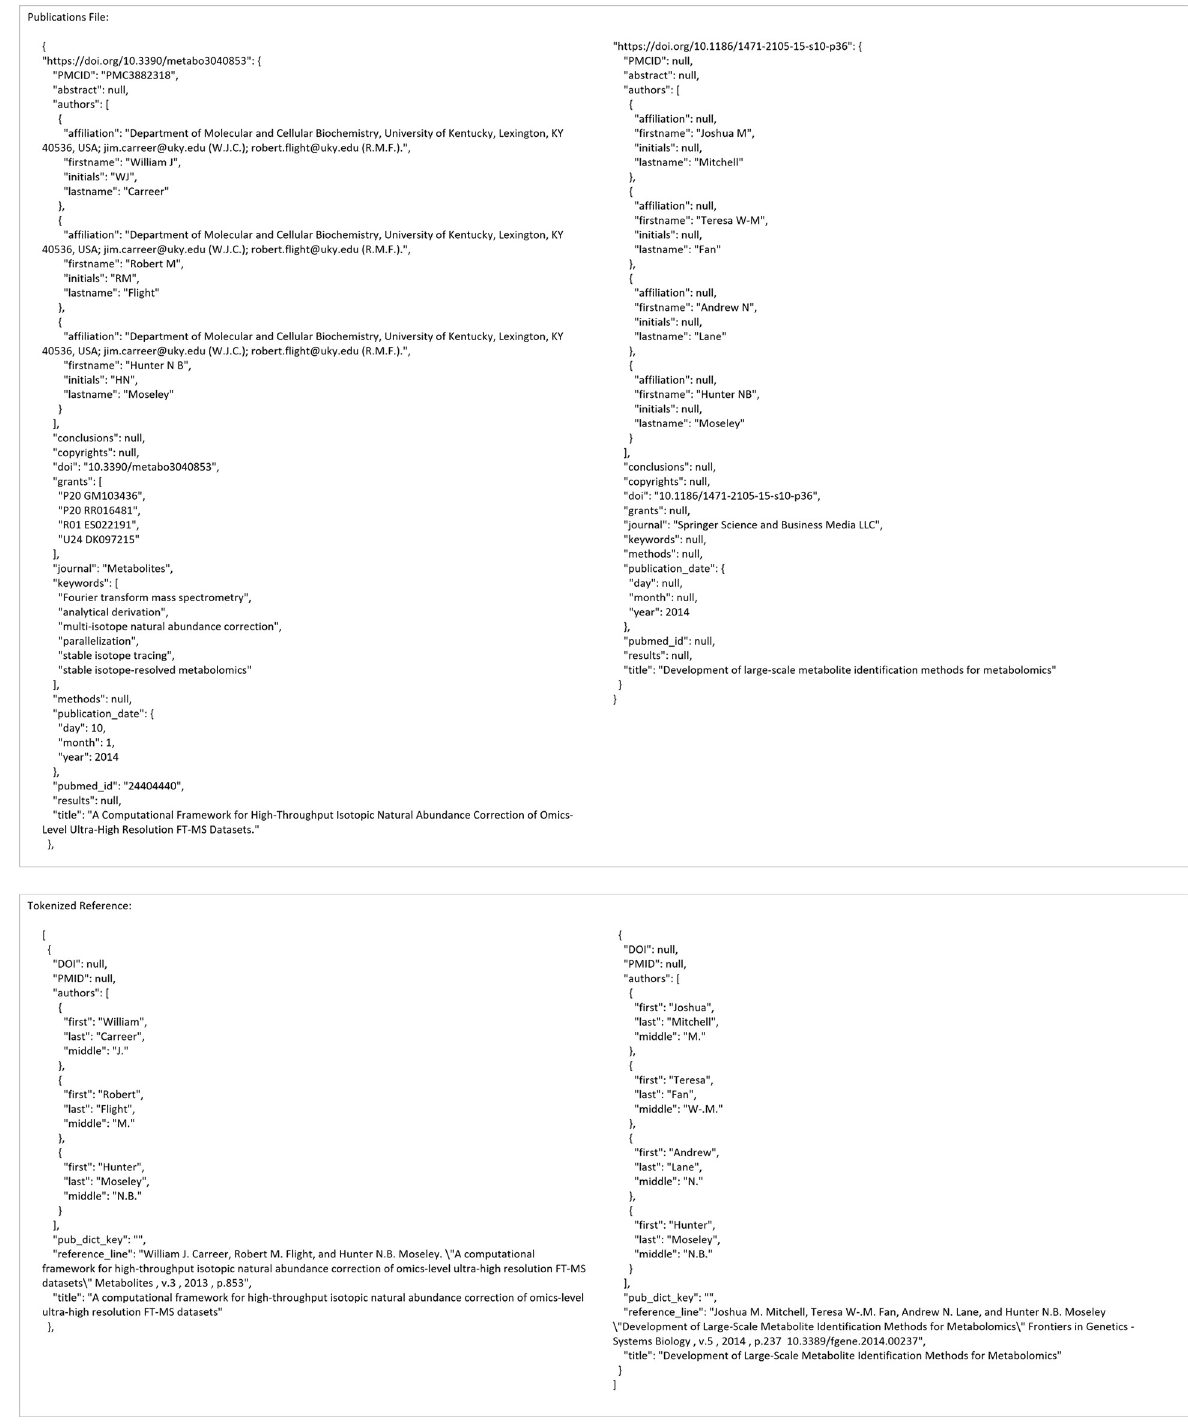
Fig 6. Publication JSON and tokenized reference contents for the reference_search use-case.